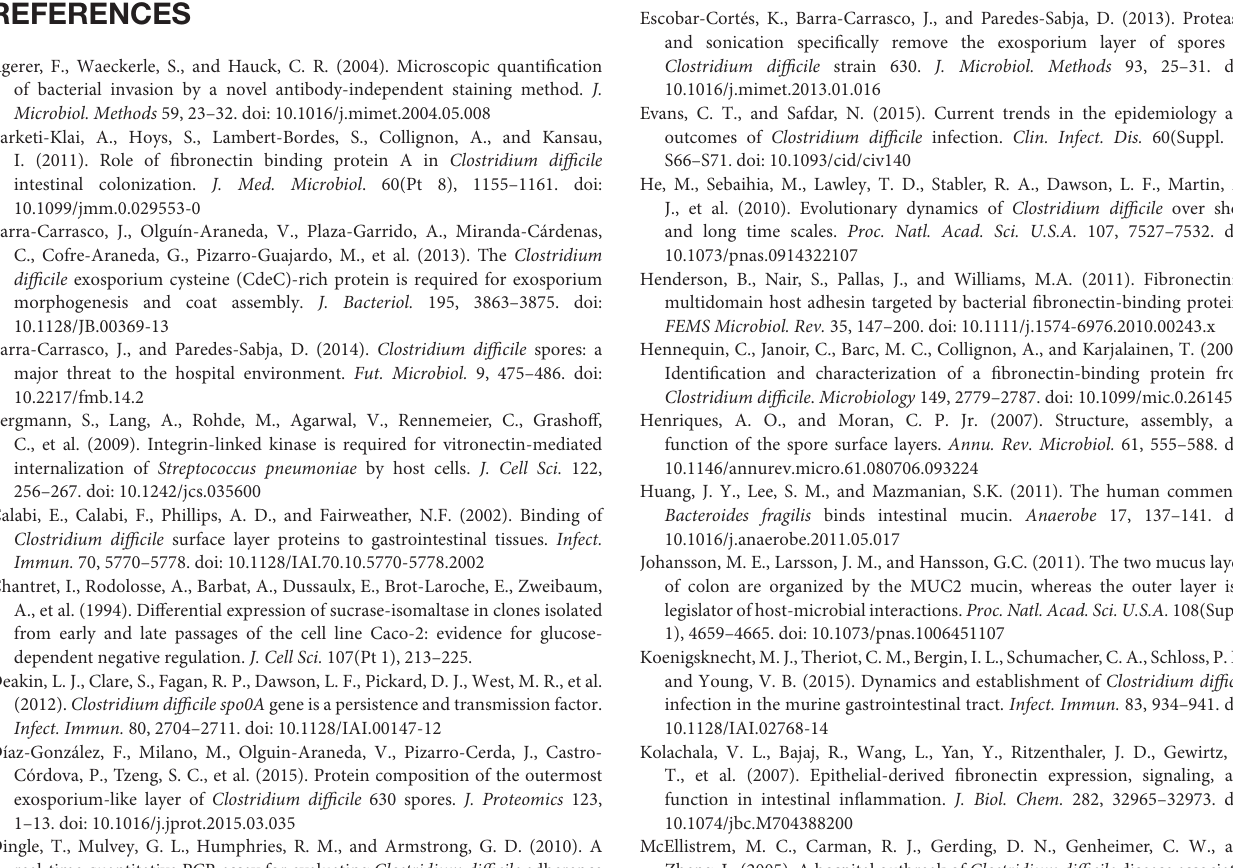
Figure S1 | Transmission electron micrographs of differentiated monolayers of Caco-2 cells. Monolayers were processed for transmission electron microscopy as described in the Method section to observe the appearance of apical microvilli. Black scale bar is shown (5 µ m). Figure S2 | Fibronectin and vitronectin-specific immunofluorescence of C. difficile spores. (A,B) C. difficile spores of wild-type (wt) and strain cdeC were incubated with various concentrations of fibronectin (A) and vitronectin (B) for 1 h at 37 ◦ C, centrifuge and stained by immunofluorescence for fibronectin and vitronectin as described in the Method section. Figure S3 | Percentage of fibronectin- and vitronectin-specific immunofluorescent positive spores. C. difficile wild-type (black bars) and cdeC spores were incubated with different concentrations of fibronectin (A) and vitronectin (B) and processed for indirect immunofluorescence as described in the Method section. Immunofluorescence micrographs were analyzed for the presence or absence of visual immunofluorescence signal. A total of 450 spores were counted. Bars represent the mean of three independent experiments and error bars represent standard error from the